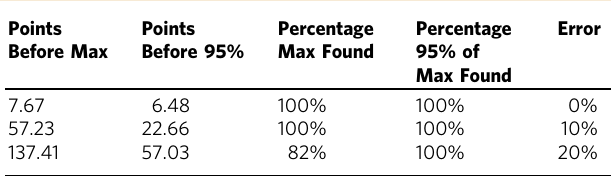
Fig. 2 Testing Bayesian optimization by fi nding the maximum of a two-dimensional function. a The acquisition function decides the next input to test and the output is used to re fi ne the predictive model. Iterations 5, 10, 15 and 20 of this process are shown. b With increasing rounds of iteration, the predictive model grows more con fi dent of the location of the global maximum and the distance between tested inputs decreases with each iteration. c The algorithm evaluated 9 points before fi nding the location of the maximum. Subsequent iterations tuned this approximation toward the true optimum. The algorithm evaluated 12 points before fi nding the maximum. The order in which each point is evaluated is shown on the graph Table 1 Effect of error on the